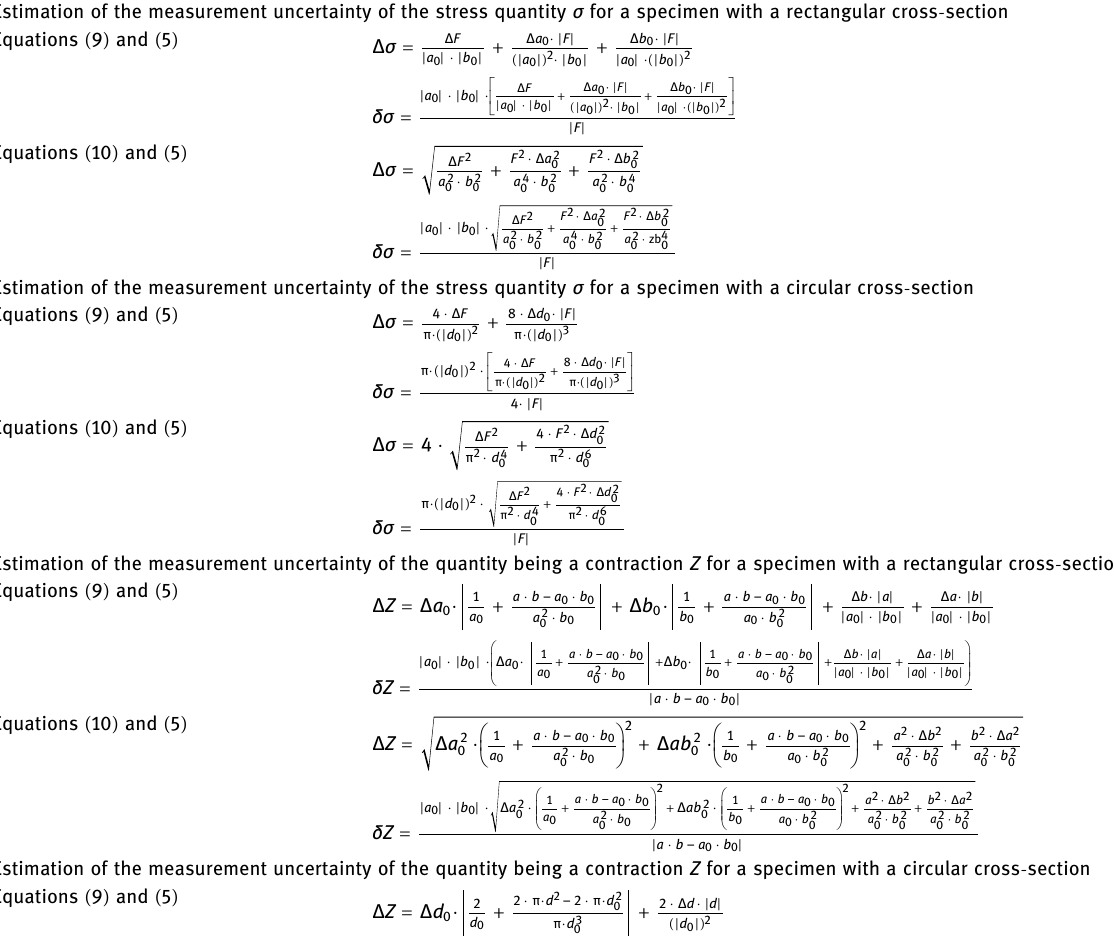
Table B1: Determination of the absolute and relative error values of strain hardening exponent n for steels used in this article Estimation of the measurement uncertainty of the stress quantity σ for a specimen with a rectangular cross - section Equations ( 9 ) and ( 5 )